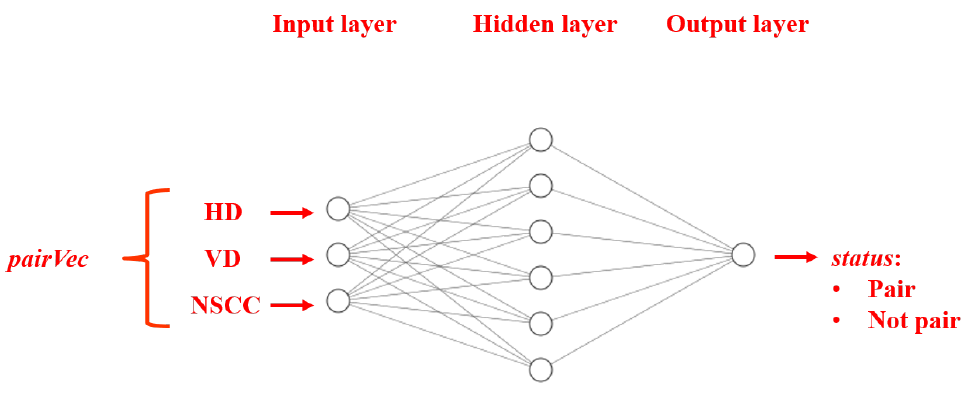
Figure 23. Neural network architecture for pairing